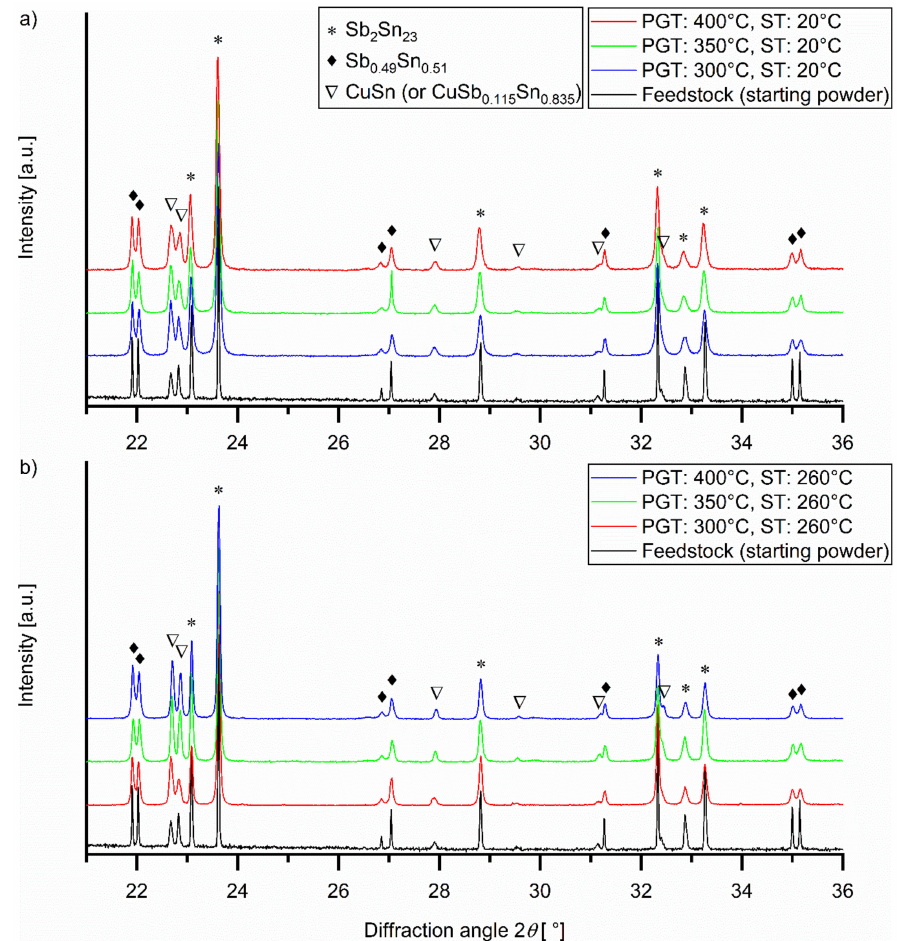
Figure 5. XRD patterns as obtained from coatings produced with the use of di ff erent PGT: ( a ) deposited on a ST of 20 ◦ C; and ( b ) deposited on a ST of 260 ◦